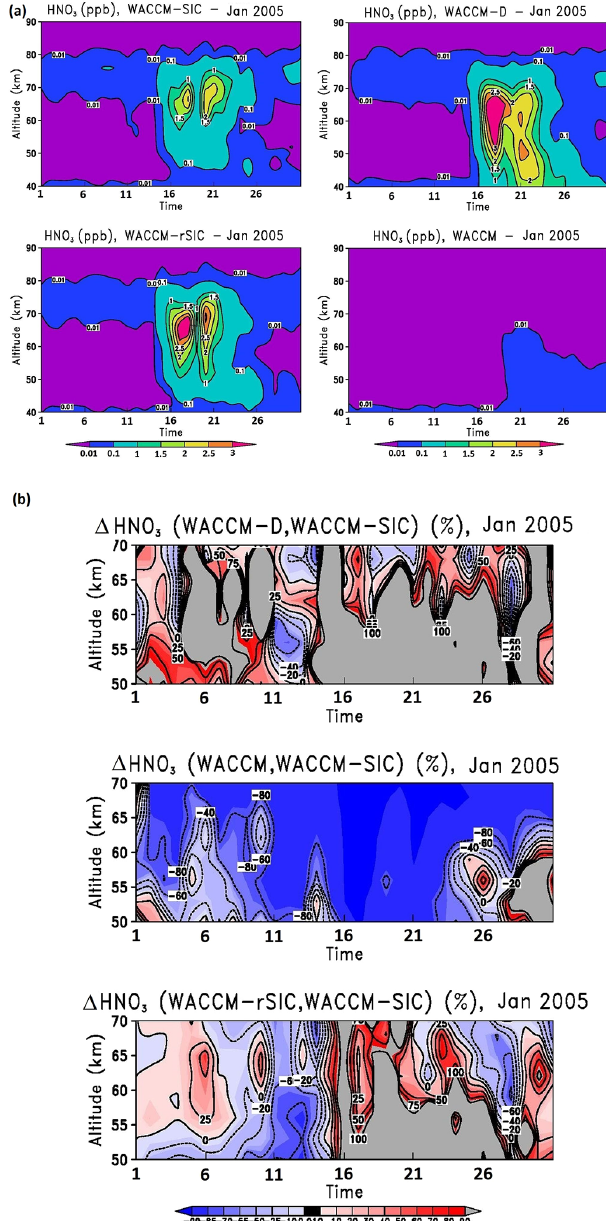
Figure 8. (a) Zonal mean vertical concentration profiles of mesospheric/upper-stratospheric HNO 3 (in ppb) for Northern Hemisphere polar latitudes (60–90 ◦ N) during January 2005; (b) percentage difference between three models (WACCM-D, WACCM and WACCM-rSIC) and the full